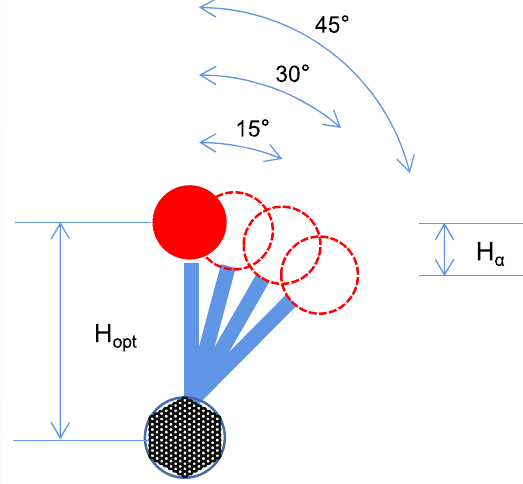
Buildings 2022 , 12 , x FOR PEER REVIEW Figure 7. Photos of plane torsion of the general cable strands. Figure 7. Photos of plane torsion of the general cable strands. Figure 7. Photos of plane torsion of the general cable strands.